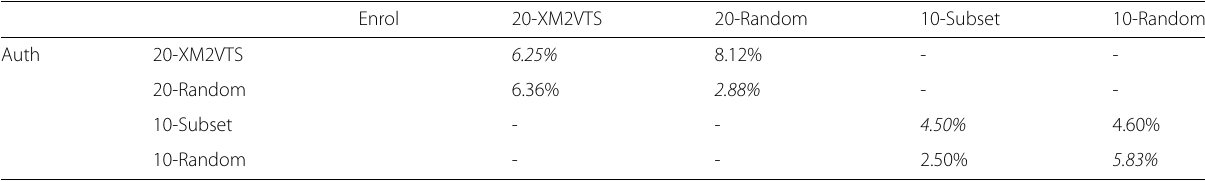
Table 7 qFace results showing the EER of the separate 10 and 20 digit